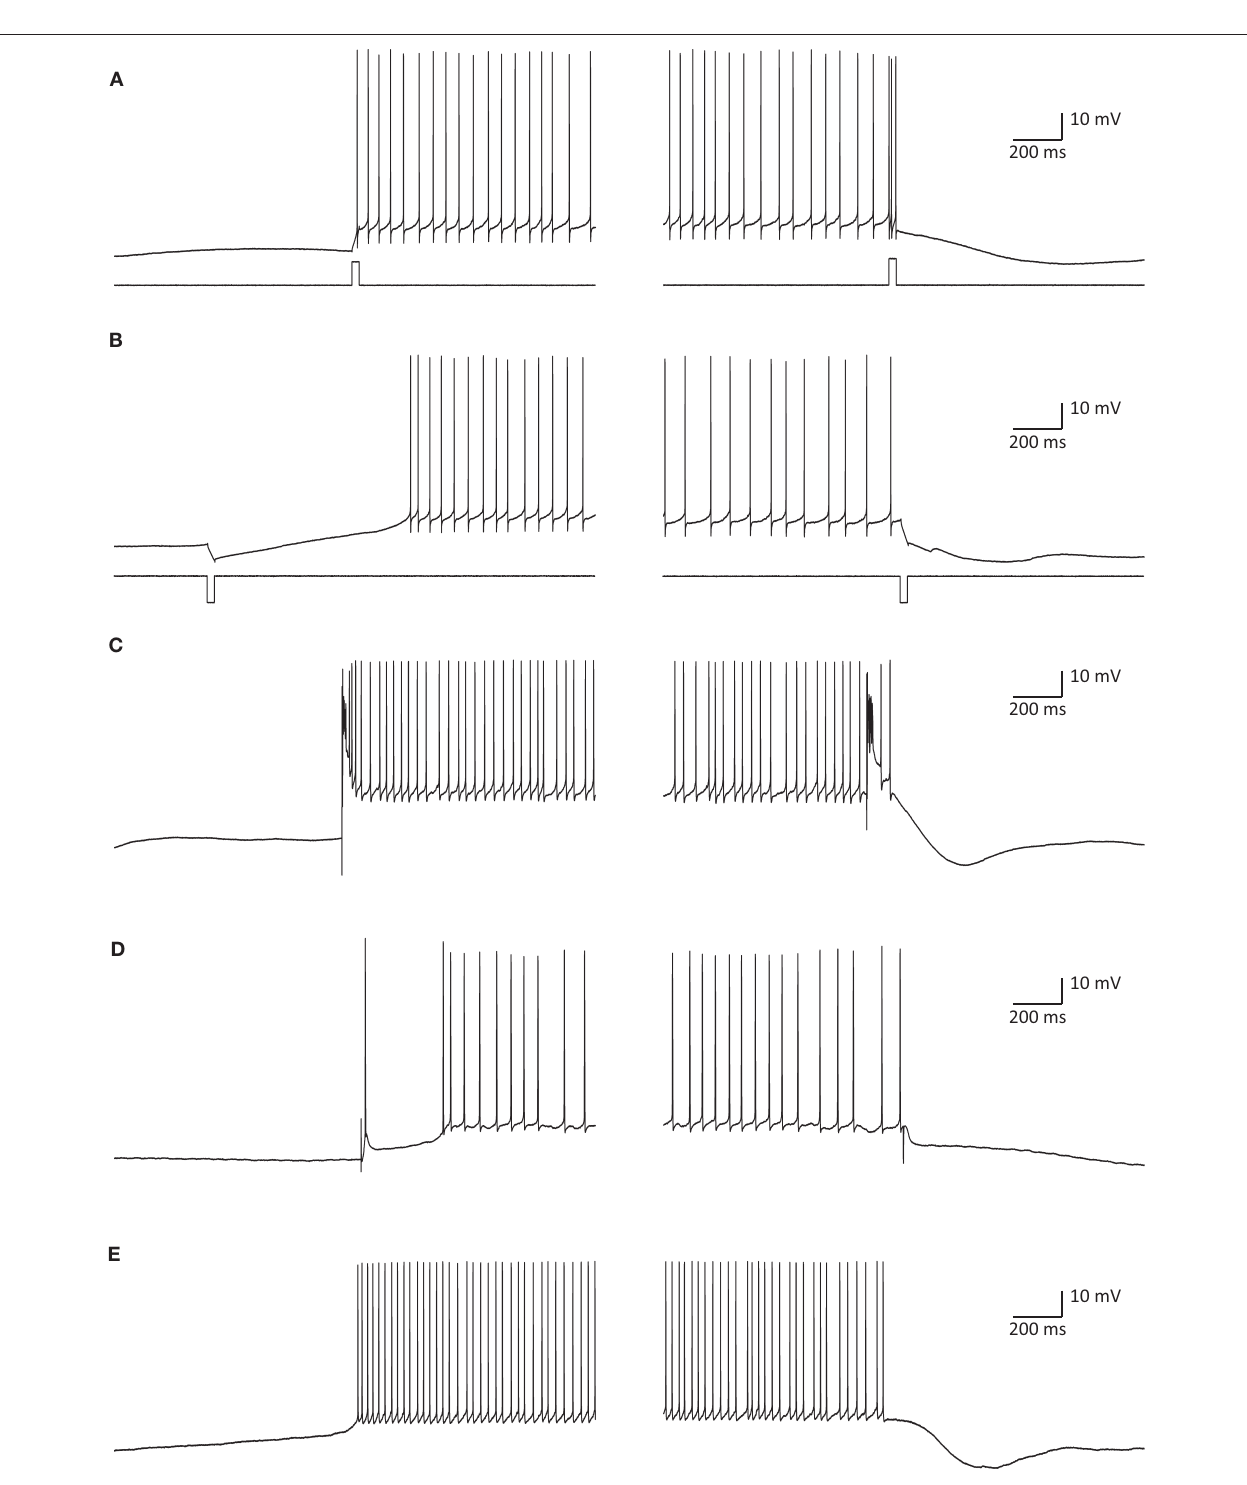
FIGURE 3 | State transitions can be induced by current injections (A,B) synaptic inputs (C,D) or can occur spontaneously (E). (A) A 35-ms depolarizing current pulse of 100 pA induced a transition to an up state (left) and to a down state (right). (B) The same as in (A) for a hyperpolarizing current pulse. (C) Transitions induced by CSs that were evoked by stimulating the white matter just below the recorded PC. (D) State transitions induced by stimulating the